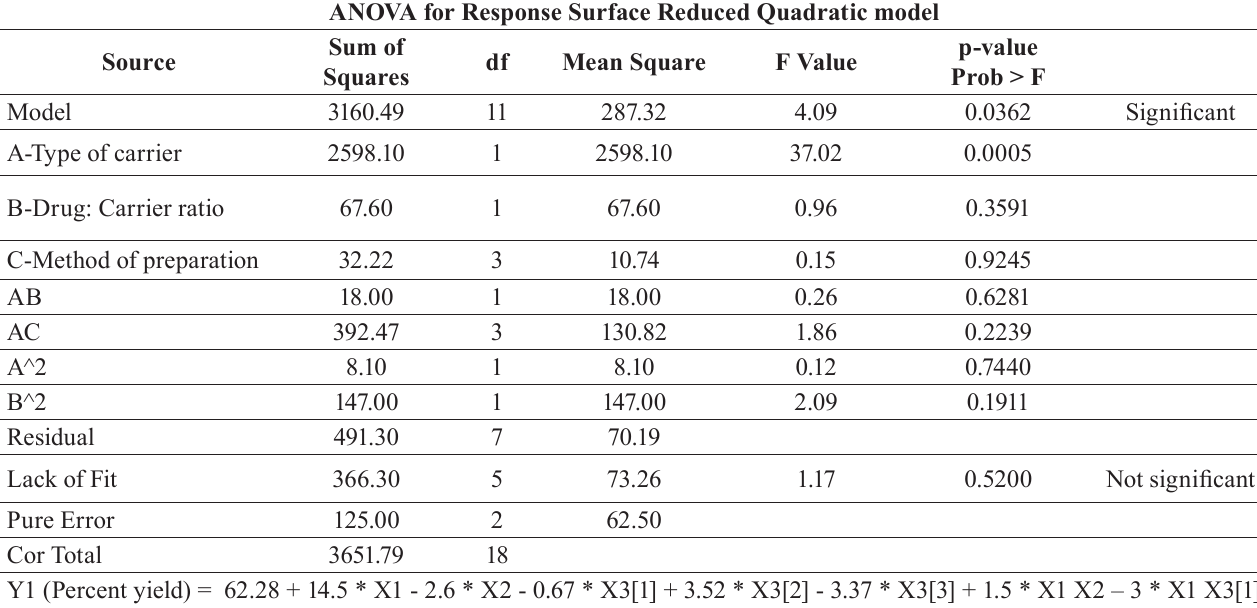
TABLE S1 - ANOVA table for the response variable percent yield along with the polynomial equation ANOVA for Response Surface Reduced Quadratic model Source